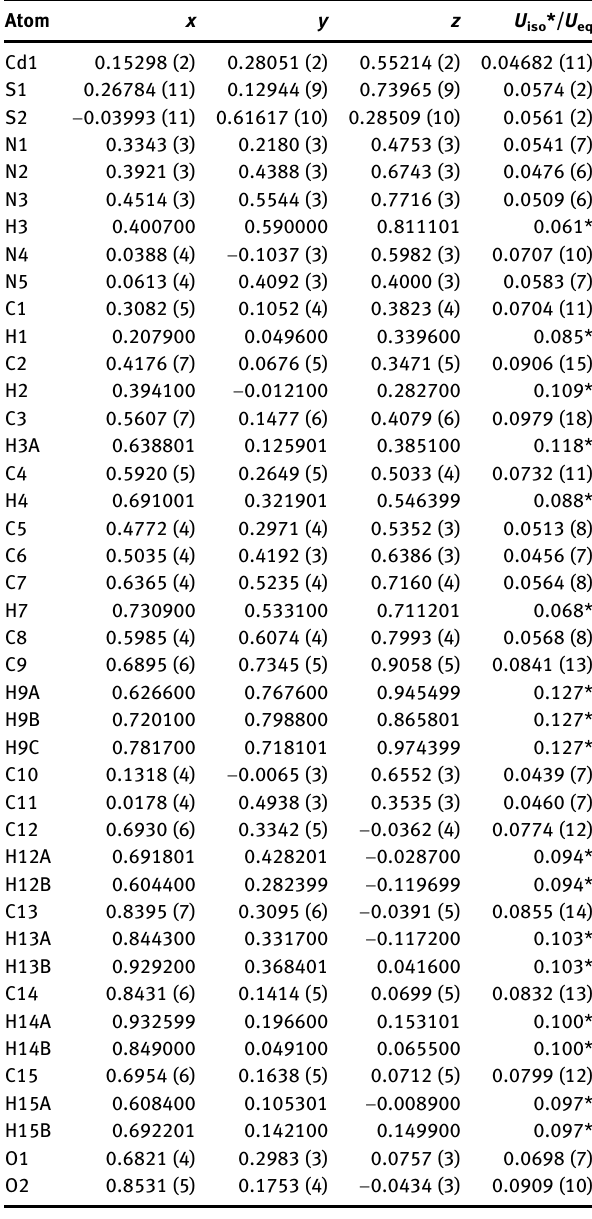
Table  : Fractional atomic coordinates and isotropic or equivalent isotropic displacement parameters (Å 